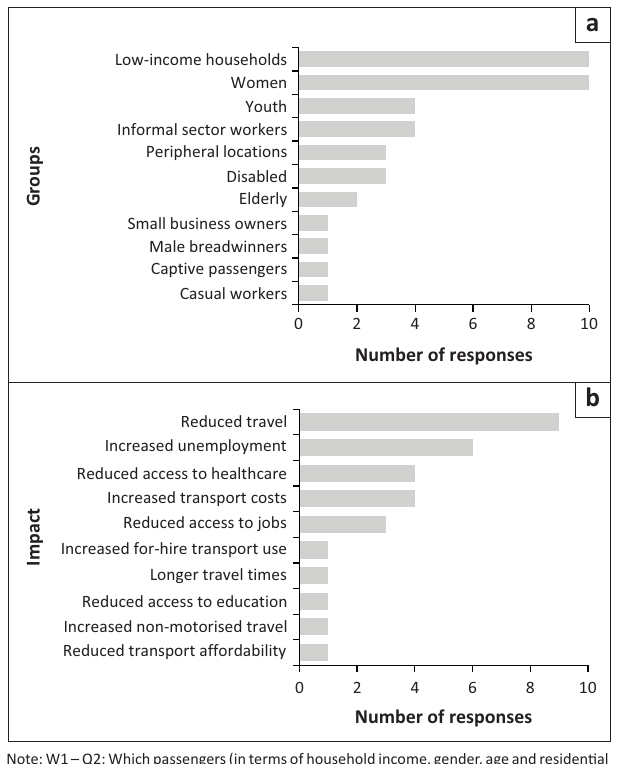
FIGURE 5: Perceived impacted groups (Delphi Wave 1, n = 15). (a) Socioeconomic and demographic groups most impacted and (b) Impacts on mobility and